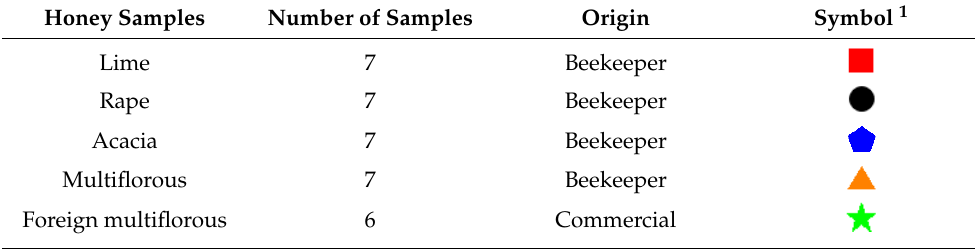
Table 3. Origin and type of honey samples with their denotations. Honey Samples